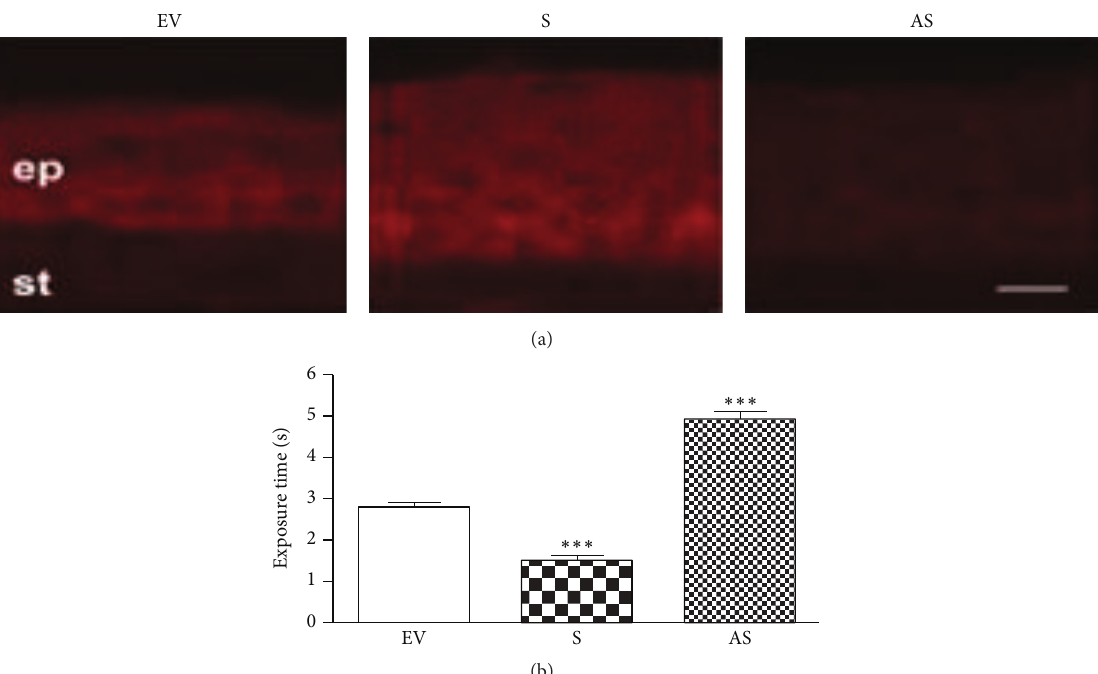
Figure 7: OGF-OGFr and molecular interactions: Gene Gun, Helios (cid:2) Gene Gun System (Bio-Rad), used for particle-mediated gene transfer, which successfully delivers sense and antisense OGFr cDNA into corneal epithelial cells. (a) Fluorescence photomicrographs of immunohistochemical staining of peripheral cornea for OGFr expression. Sense (S) results in overexpression of OGFr. Antisense (AS) results in diminished expression of OGFr. Empty vector (EV) has no effect. (b) Histograms illustrate immunoreactivity response to particle-mediated transfection with empty vector (EV), sense (S), or antisense (AS). ∗∗∗ 𝑃 < 0.001 . Note: the 𝑦 -axis is exposure time so an increased exposure time required for detection of the OGFr indicates a decreased amount of OGFr present in the sample (derived from [13]). All stained with OGFr